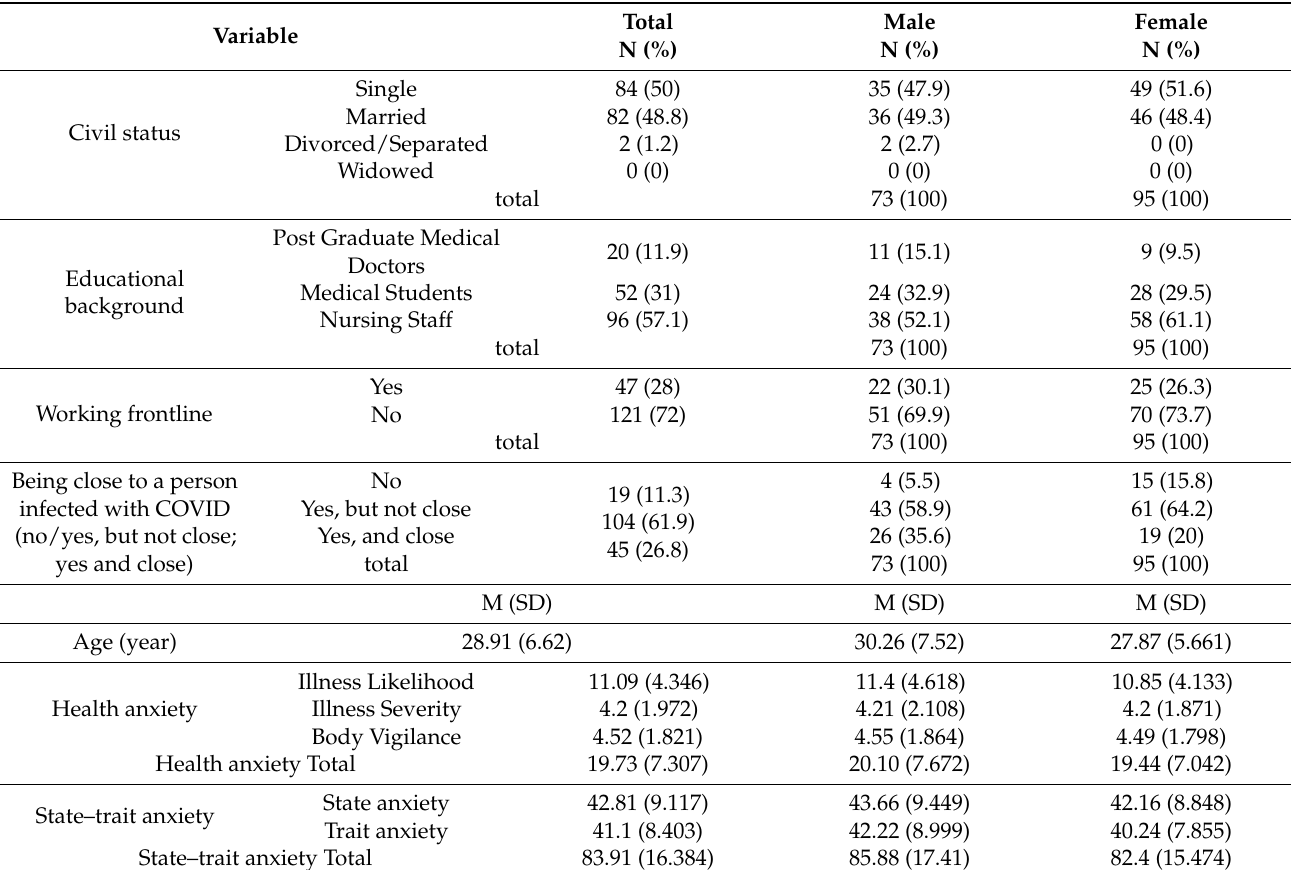
Table 1. The overview of sociodemographic and questionnaire-related descriptive